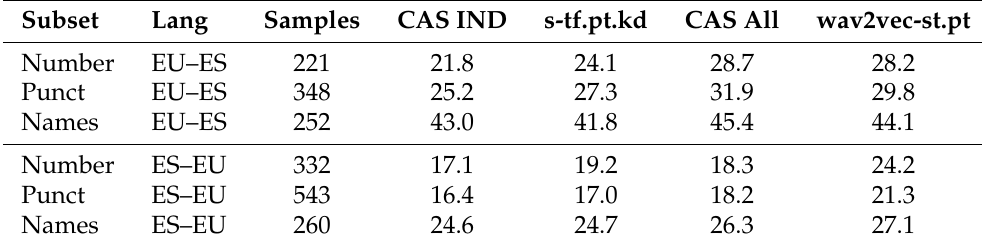
Table 15. BLEU results on selected test subsets